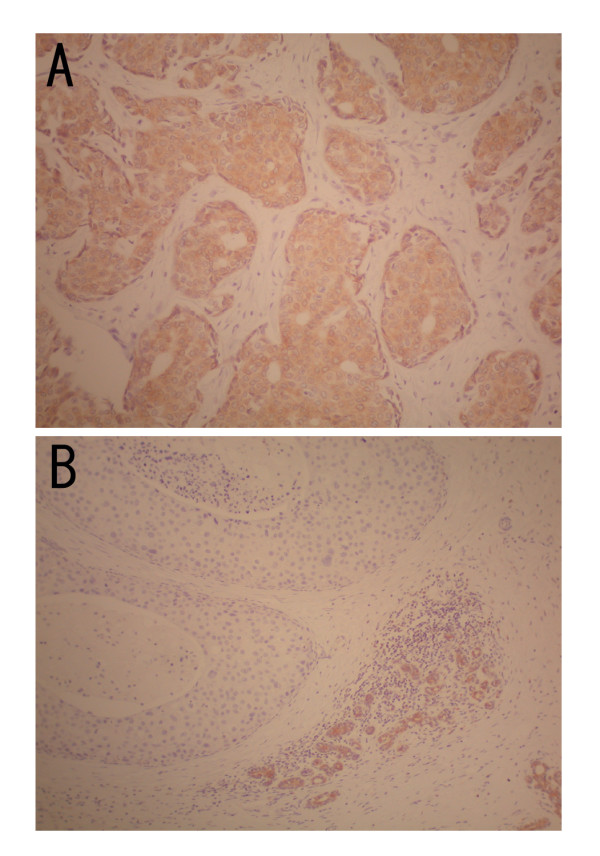
Immunohistochemical expression of Bcl-2 protein in breast cancer. A: a case with a normal expression of Bcl-2 protein in breast cancer cells. B: a case with a decreased expression of Bcl-2 protein, in which the expression of Bcl-2 protein of breast cancer cells decreased in comparison to a normal expression of Bcl-2 protein in normal mammary gland.